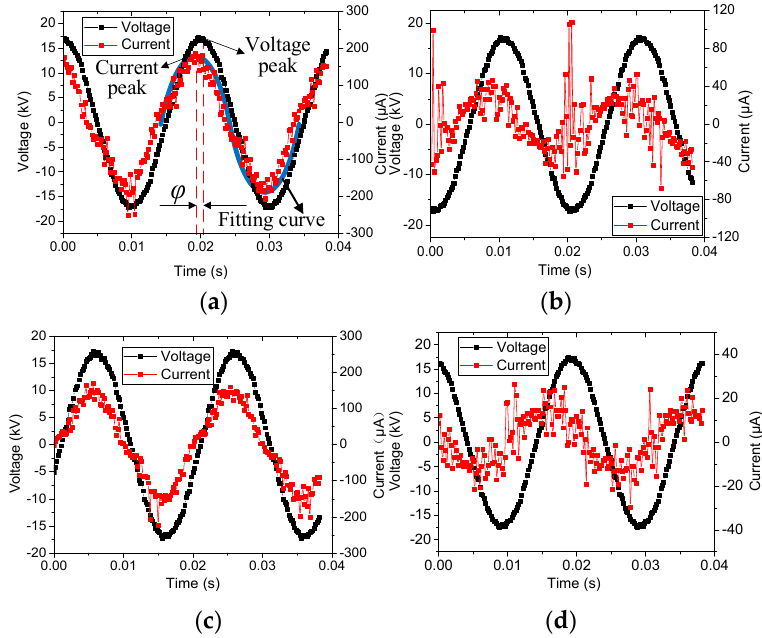
Figure 13. Voltage and current waveforms of sample L4 by the conventional and new electrode setups: ( a ) Total current; ( b ) Interface current; ( c ) Outer sheath current; ( d ) Core rod current.